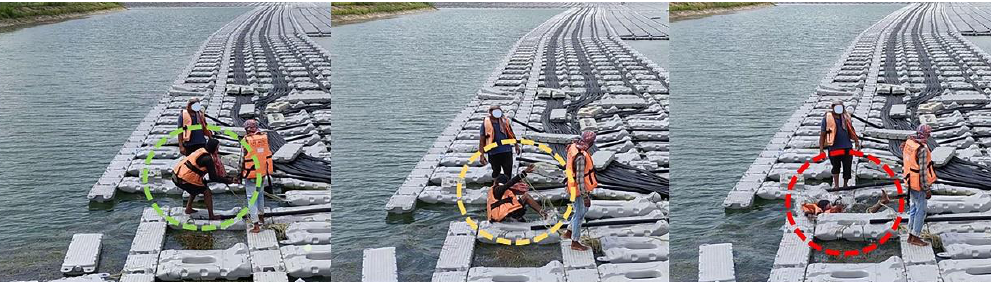
Figure 1. A worker is seen falling (marked in circles) due to an unstable working platform during installation of a solar photovoltaic project in India (image source: authors).